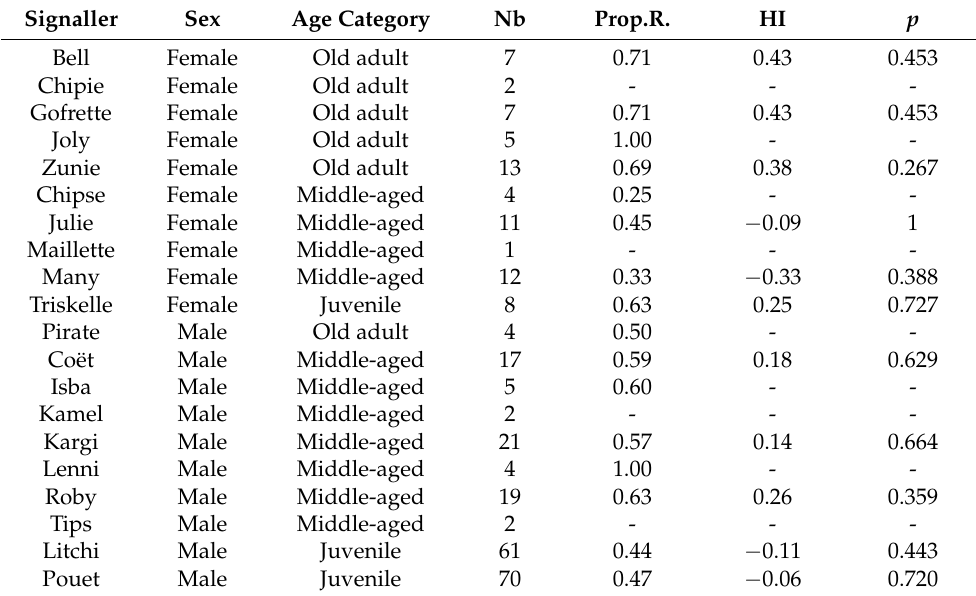
Table 5. Nb: number of unimodal gestures; Prop.R: proportion of gestures produced with the right hand; HI: handedness index; p : binomial test p